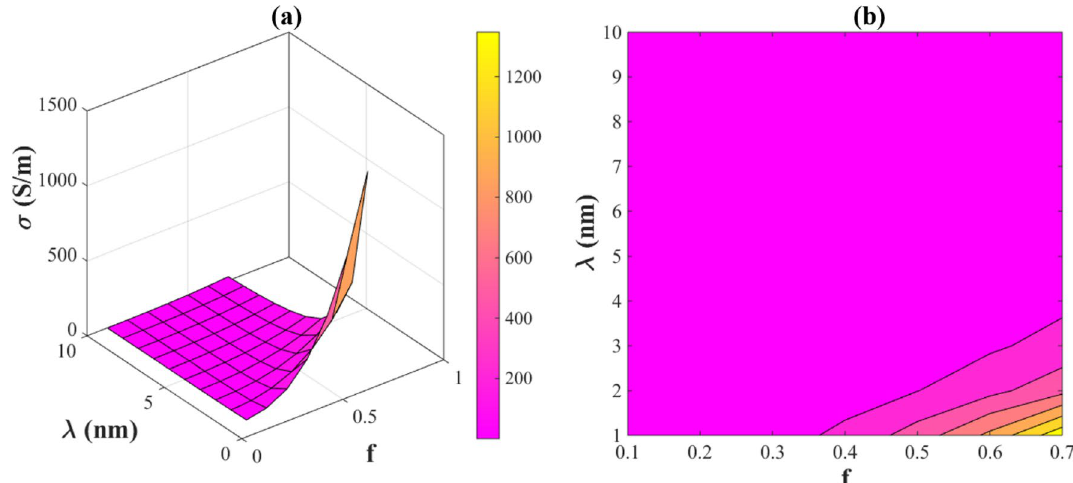
Figure 3. The impacts of “f” and “λ” on the electrical conductivity of PNCs by ( a ) 3D and ( b ) contour